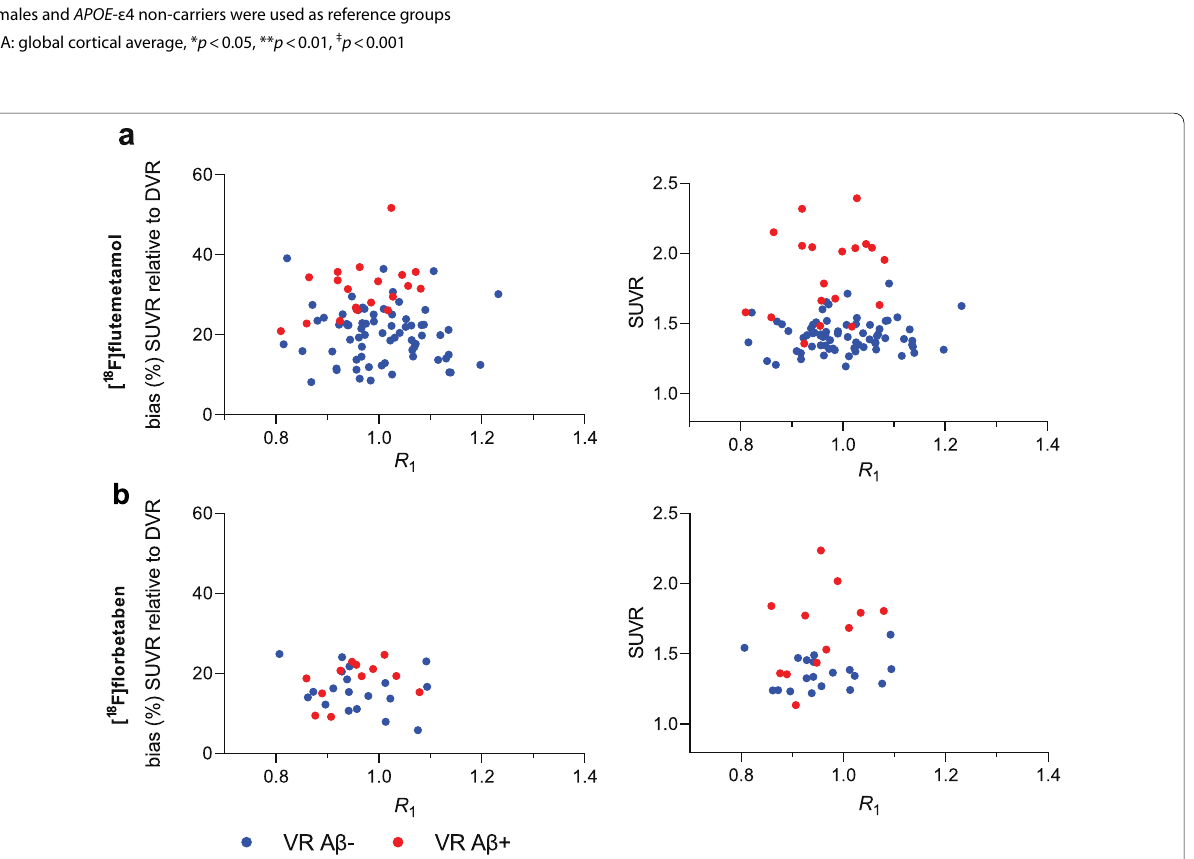
Females and APOE -ε4 non-carriers were used as reference groups